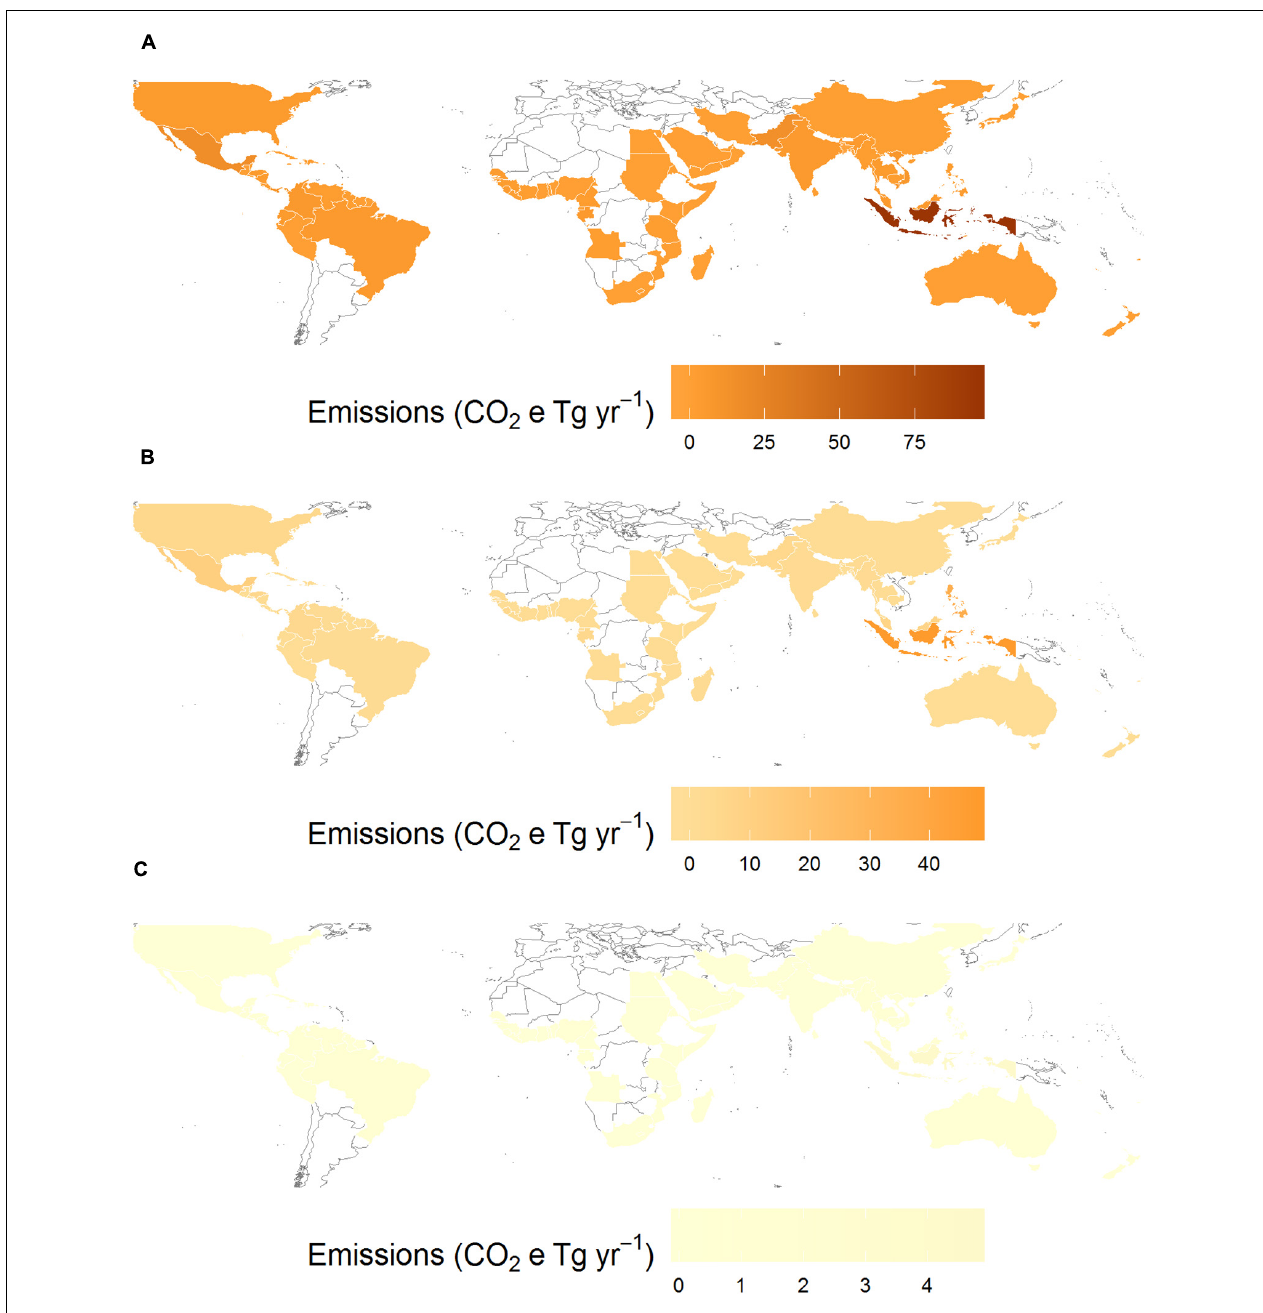
FIGURE 3 | Decadal global CO 2 e emissions from mangrove deforestation from (A) 1980; (B) 1990 and (C)